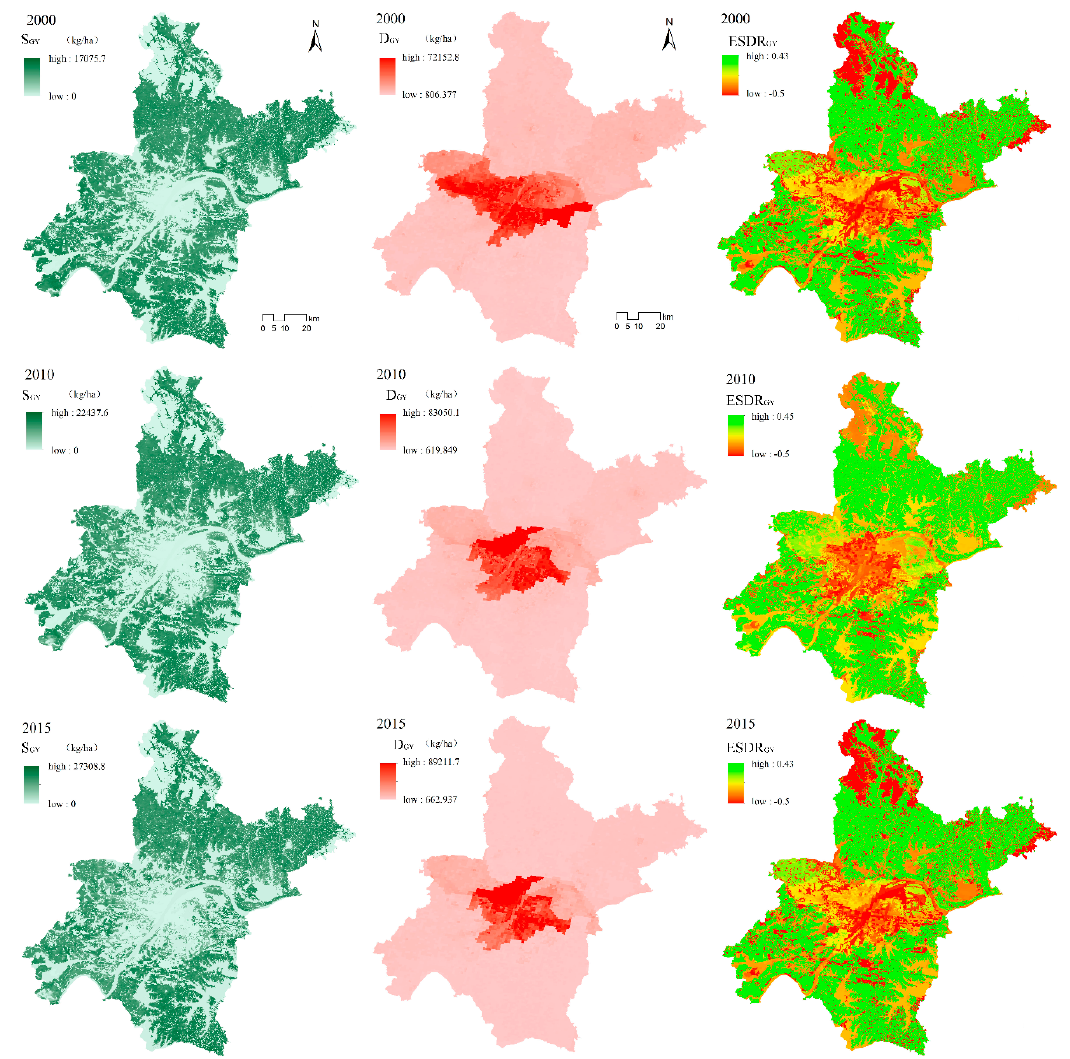
Figure 3 . Spatial distribution of supply, demand, and supply–demand ratio of grain yield service in Wuhan in 2000, 2010, and 2015